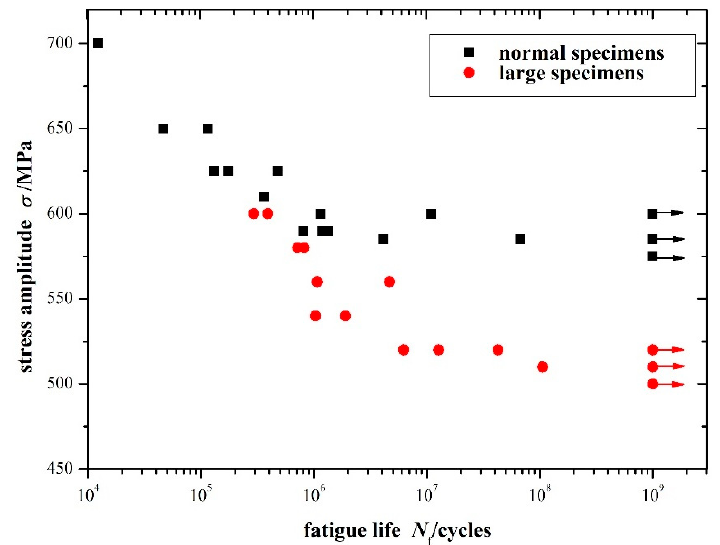
Figure 4. The very high cycle fatigue S-N curve of large specimens.